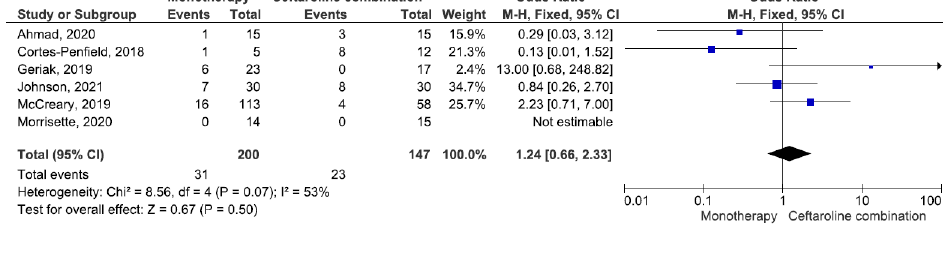
Figure 4. Forest plots and funnel plots for adverse events between monotherapy and combination therapy in the treatment of methicillin-resistant Staphylococcus aureus bacteremia.